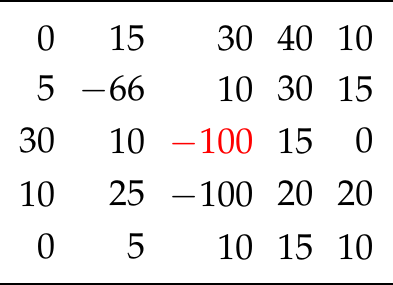
Figure 3. The sample 2D data grid. The values for the product V are displayed.